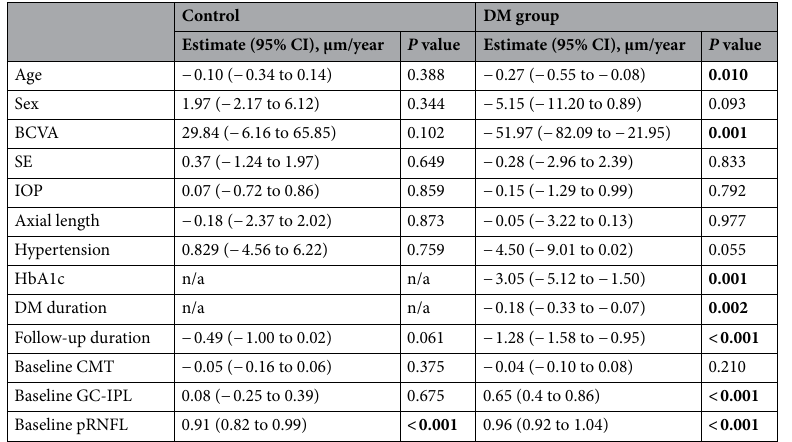
Table 3. Results of linear mixed models assessing the effects of putative factors predicting changes in mean peripapillary retinal nerve fiber layer (pRNFL) thickness over time. BCVA best− corrected visual acuity, SE spherical equivalent, IOP intraocular pressure, CMT central macular thickness, GC-IPL ganglion cell-inner plexiform layer. Values in boldface ( P < 0.05) are statistically